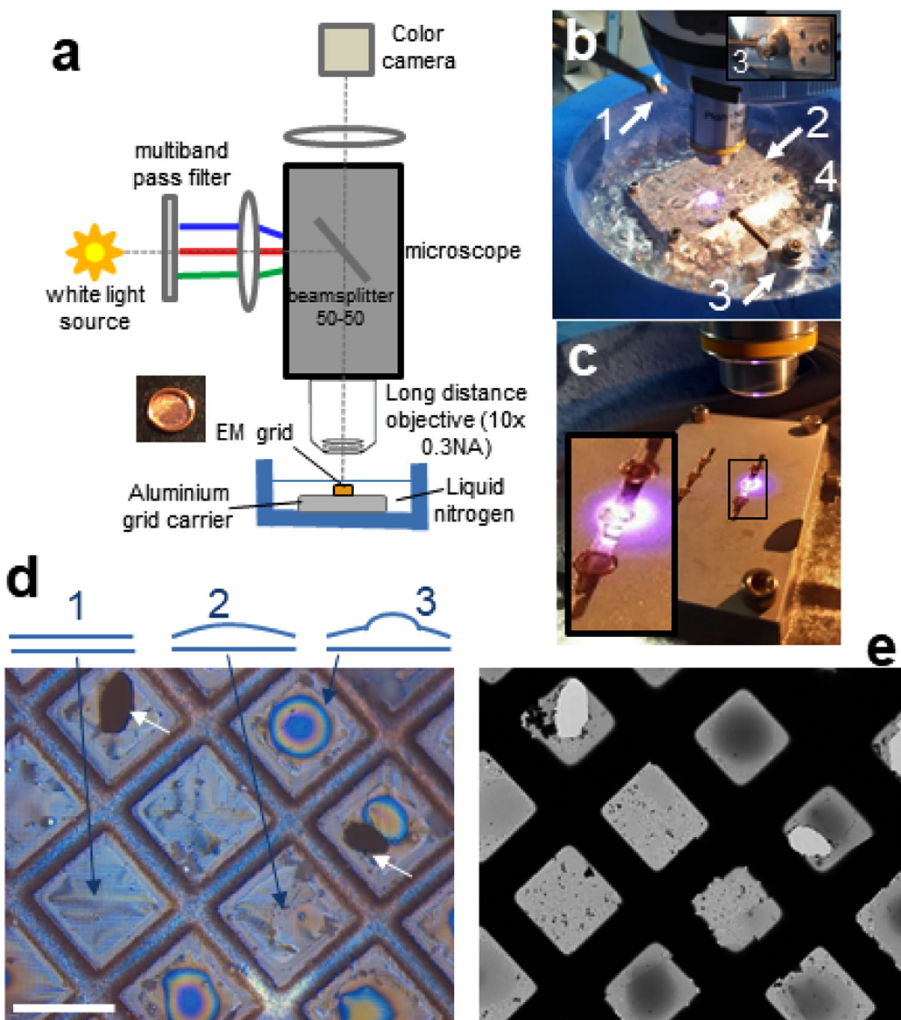
Figure 1. Experimental setup for interferometric microscopy at cryogenic temperature. ( a ) Optical setup. The insert shows an exemplary EM grid that will be coated with a vitrified ice layer containing the protein complex. ( b ) Image of the custom-made cryo-stage filled with liquid nitrogen, also showing the tweezer holding the grid coated with sample (arrow 1), the aluminium heat sink supporting the grid (arrow 2), the grid-box transfer mount (arrow 3, magnification from another view in the top right corner), and a grid-box (arrow 4). ( c ) Picture of the aluminium heat sink on which grids are placed for imaging. The insert shows a magnification showing three grids, the middle one being illuminated by the three-wavelength light through the microscope objective. ( d ) Top: schematic diagrams of grid hole cross-sections of (1) ideal ice thickness where the particles tightly fit, (2) region with thicker ice regions in which particle density is too high for optimal cryo-EM imaging, and (3) too thick ice with the presence of water droplets not suitable for the measurements. Bottom: typical interferometric image of a grid coated with an ice layer containing the sample. The interference colour patterns reveal the presence of the characteristic regions described on top (three different cases indicated by the arrows). Scale bar 50 µm. ( e ) Corresponding low-magnification EM image of the same grid region. The EM user usually estimates ice thickness based on the brightness of the images inside the holes of the grids since a thicker ice layer transmits less electrons than a thinner film. The comparison with the interferometric in ( d ) confirms the presence of different ice layer thicknesses (top in d ), as identified by the coloured interference